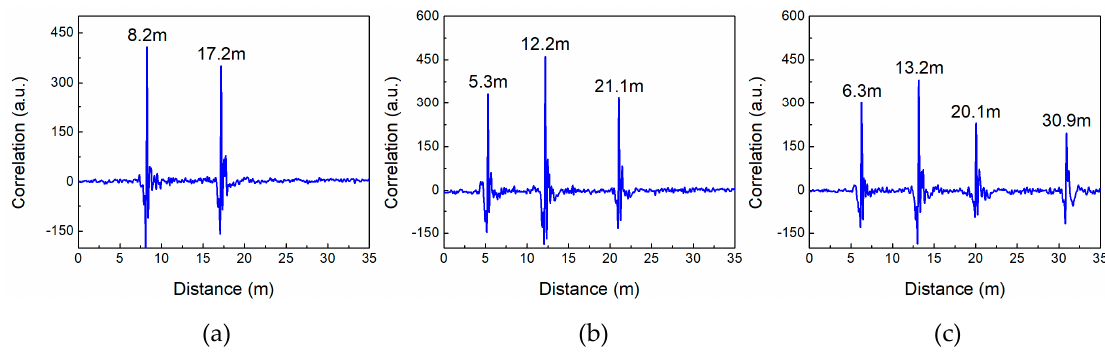
Figure 9. Detection results of ( a ) two intruders, ( b ) three intruders and ( c ) four intruders.